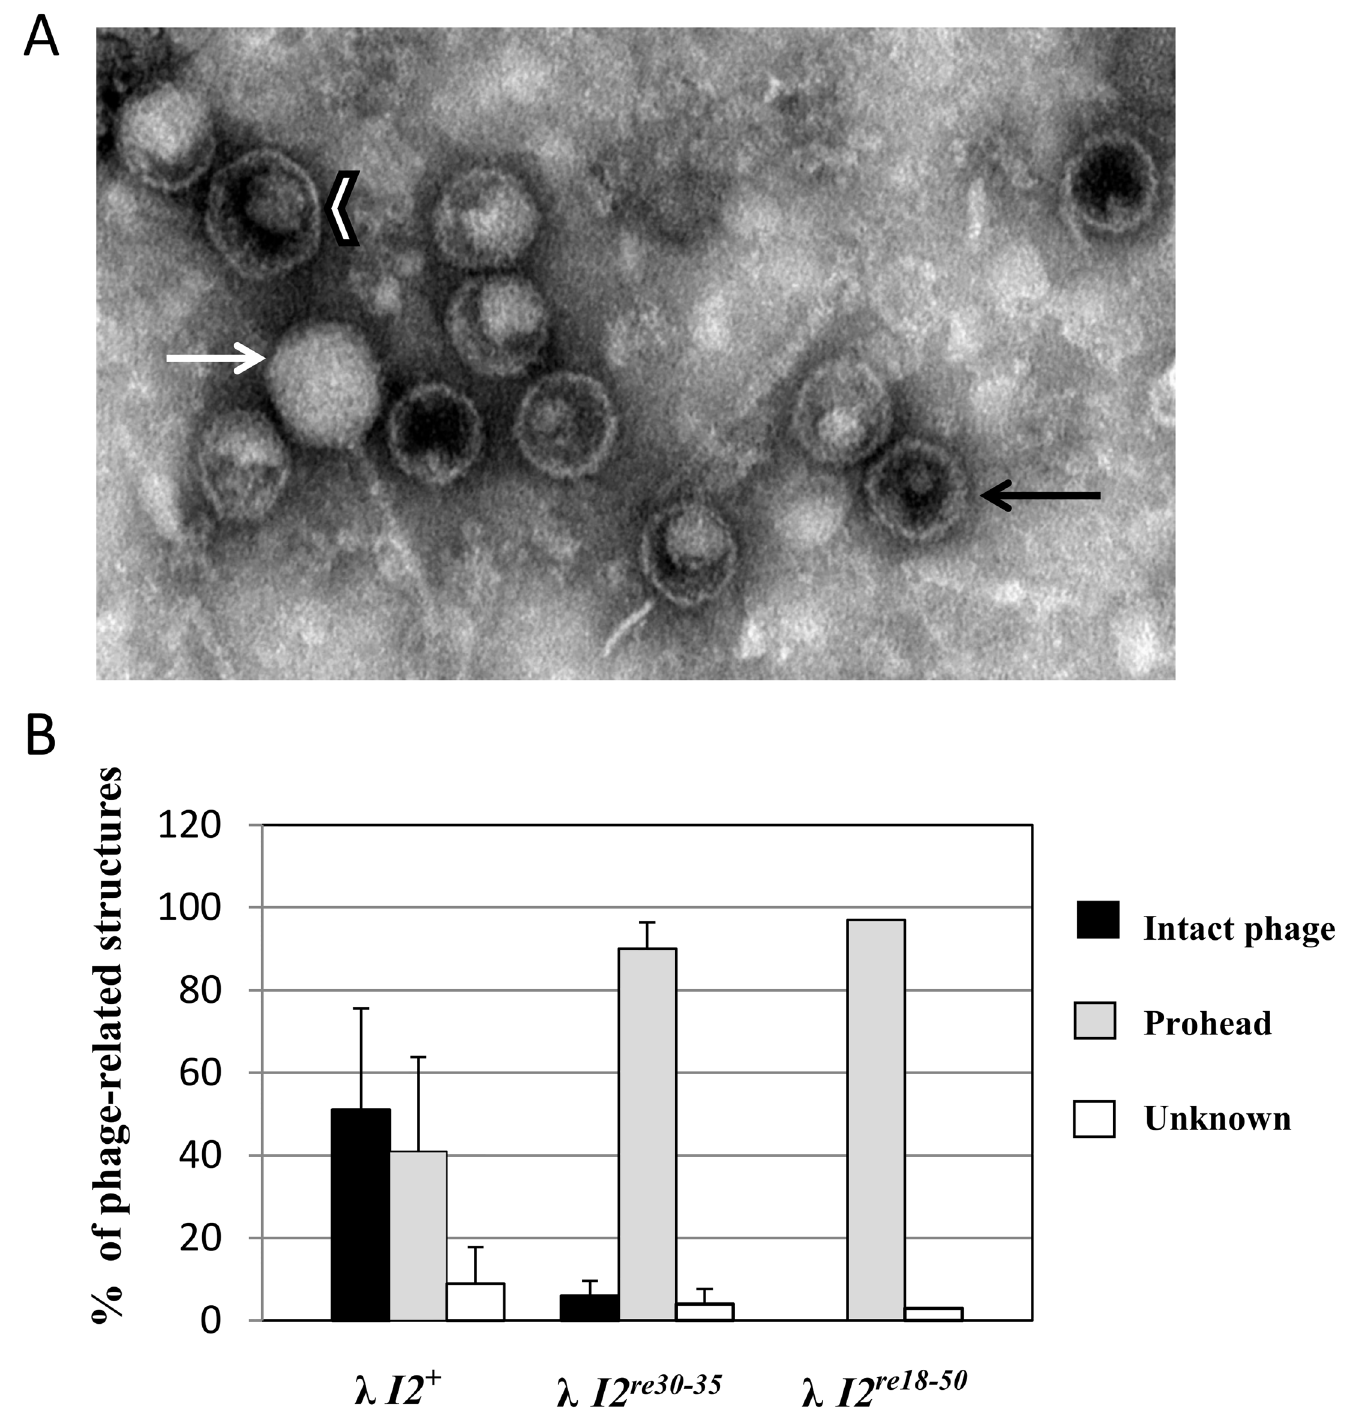
Fig 4. Effects of I2 mutations on the production of phage-related structures. A. Electron micrograph of phage-related structures in a λ -P1 wild type lysate. Symbols: black arrow = prohead; white arrow = intact phage; white chevron = unknown structure. B. Quantitation of phage-related structures in phage lysates. Total numbers of particles observed were: λ -P1 I2 + — 419; λ -P1 I2 re30-35 – 700; and λ -P1 I2 re18-50 – 100. Error bars represent standard deviations of data averaged from several EM preparations. For the I2 re18-50 lysate, a single EM preparation was examined.